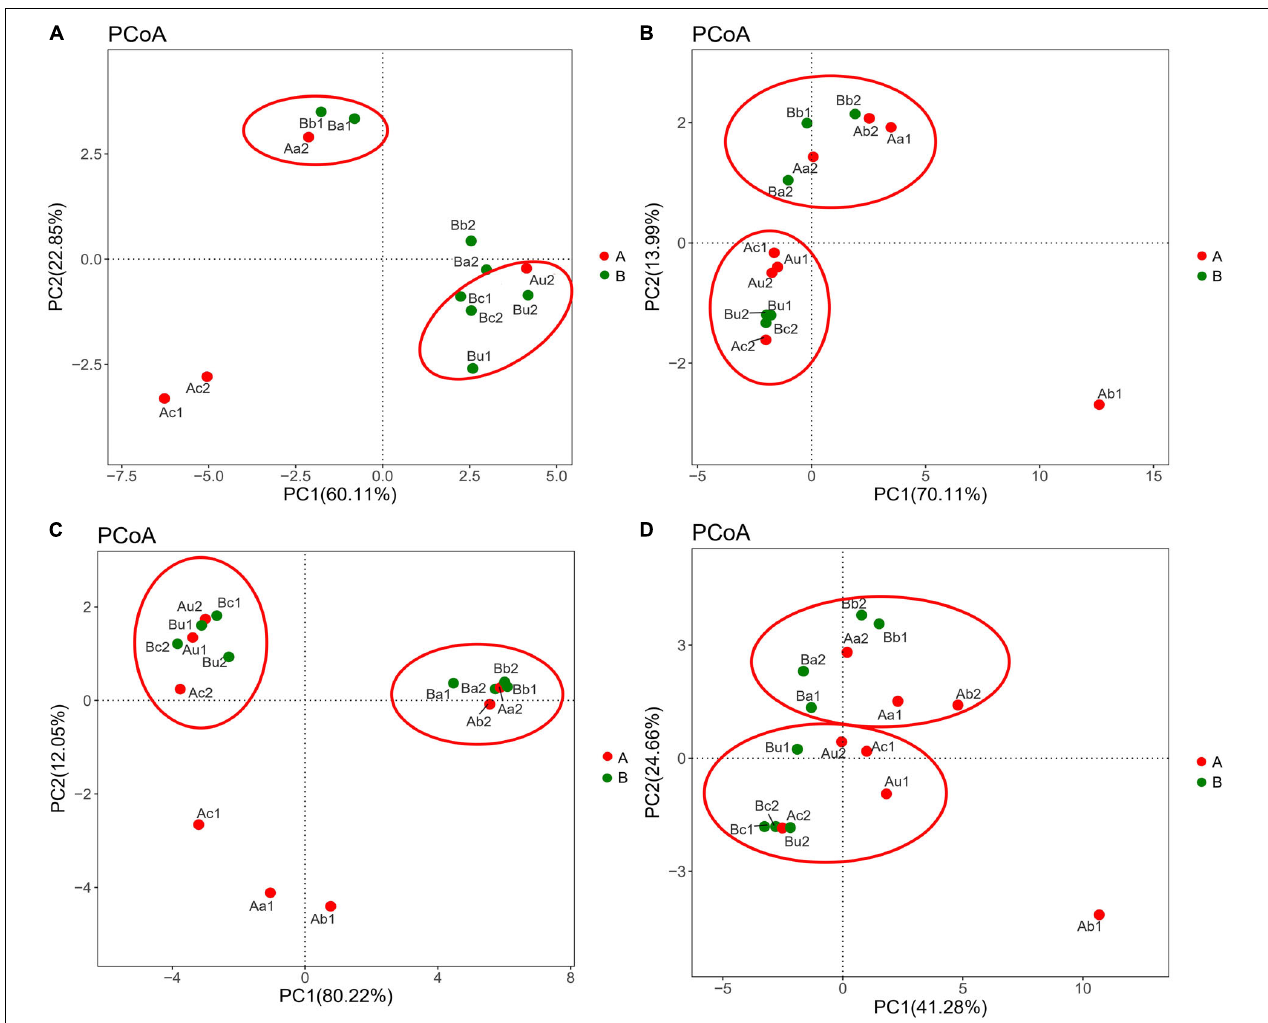
FIGURE 5 | Difference in distribution of microbial community of panels (A) AOA, (B) AOB, (C) NOB, and (D) 16S rRNA V4–V5 region in different samples in the two devices. Data were obtained based on the phylogenetic lineages using the weighted Fast UniFrac PCoA. The red ellipse indicates that different samples with similar microbial community structure are clustered